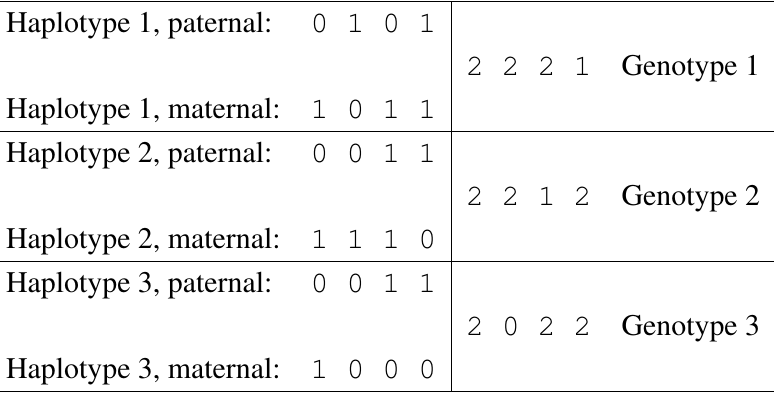
Figure 6. Haplotypes and corresponding